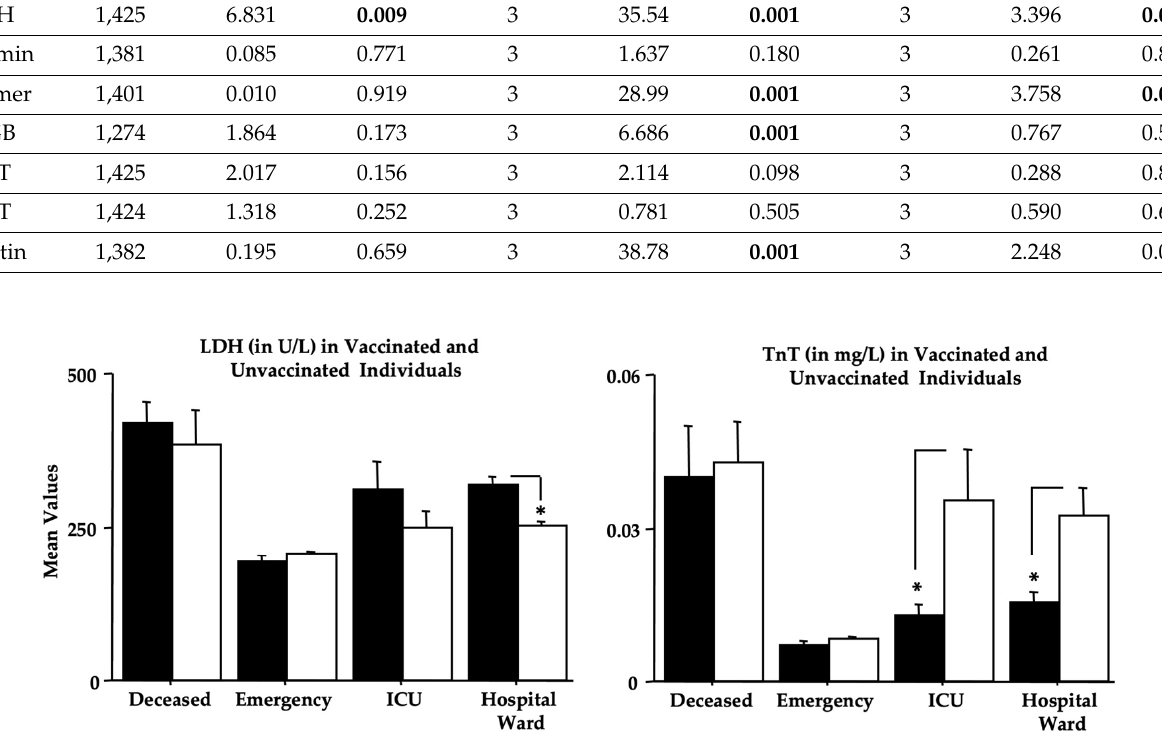
Figure 9. Vaccination effects on LDH and TnT (see Section 3). The error bars indicate pooled standard error means (SEM) derived from the appropriate error mean square in the ANOVA. The asterisks (* p < 0.05) indicate post hoc differences between groups.